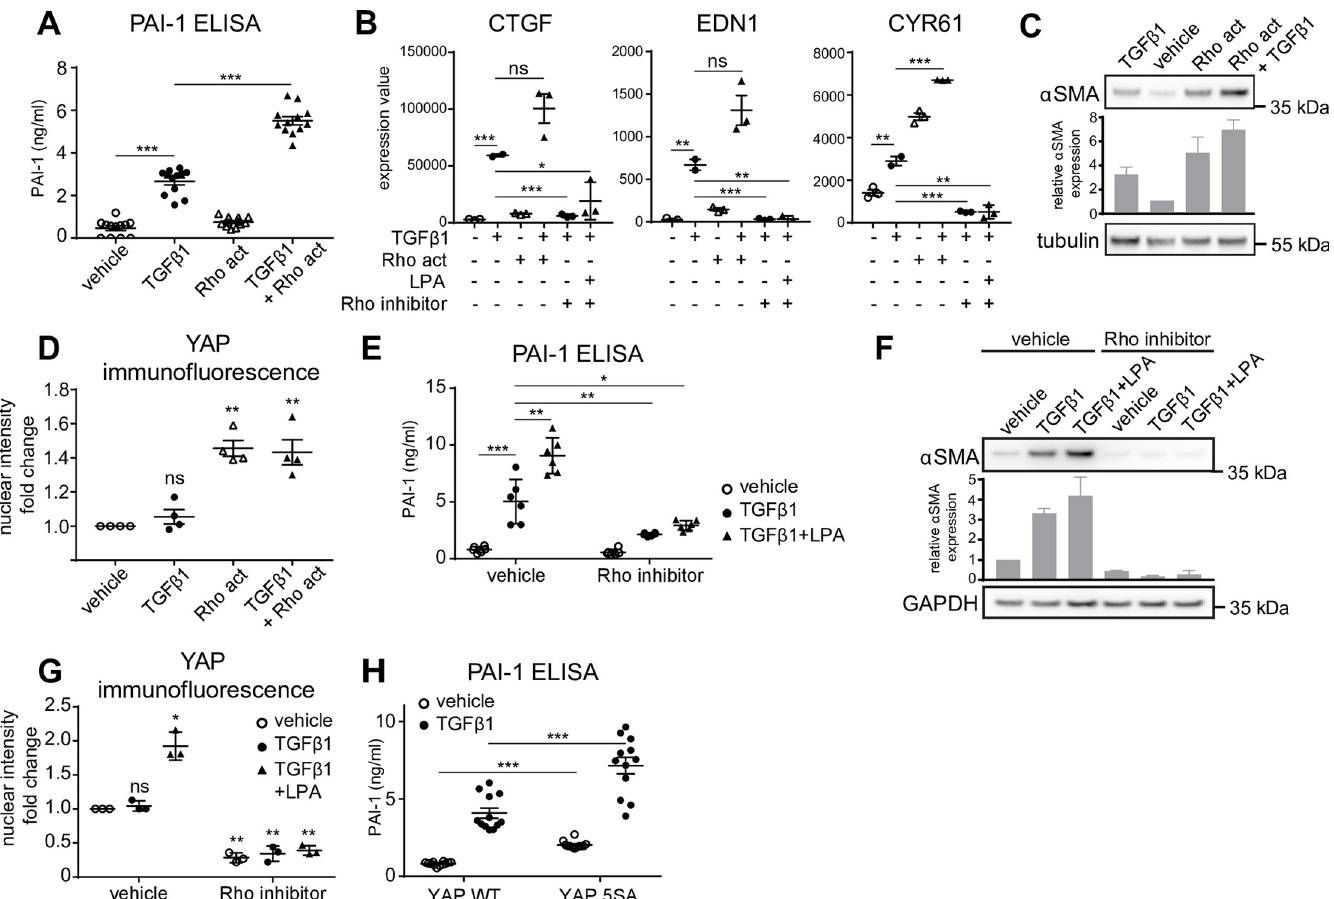
Fig 3. GPCR ligands regulate TGF β 1 response via the Rho/YAP axis. (A) Human dermal fibroblasts were starved and stimulated with 5ng/ml TGF β 1, 1ng/ml of Rho activator (Rho Act) or a combination of the two. PAI-1 levels in the cell supernatant were measured by ELISA after 24h (n = 9). Mean+/- SEM. (B) CTGF, EDN1 and CYR61 expression was measured by RT-qPCR after 3h in NHDF treated as indicated (n = 3). Mean+/- SEM. (C) α SMA levels were determined by western blot at 24h in cells treated as in A. The signal for α SMA was measured by image densitometry and expressed as relative value compared to vehicle-treated sample (n = 2). Mean+/- SEM. (D) NHDF were starved and stimulated with 5ng/ml TGF β 1, 1ng/ml of Rho activator (Rho Act) or a combination of the two for 1h. The nuclear intensity of YAP was analyzed by high content imaging of cells stained with anti-YAP antibody. Results were normalized to vehicle-treated cells (n = 4). Mean+/- SEM. One sample t-test was performed comparing normalized treatment effects to value 1 (vehicle). (E, F) NHDFs were starved, pretreated with Rho inhibitor (2ng/ml) and stimulated with 5ng/ml TGF β 1, 1 μ M LPA or the combination. PAI-1 levels in the cell supernatant were measured by ELISA after 24h (n = 6). Mean+/- SEM. α SMA levels were determined by western blot at 24h. The signal for α SMA was measured by image densitometry and expressed as relative value compared to vehicle-treated sample (n = 2). Mean+/- SEM. (G) NHDFs were starved, pretreated with Rho inhibitor (2ng/ml) and stimulated with 5ng/ml TGF β 1, 1 μ M LPA or the combination for 1h. The nuclear intensity of YAP was analyzed by high content imaging of cells stained with anti-YAP antibody. Results were normalized to vehicle-treated cells (n = 3). Mean +/- SEM. One sample t-test was performed comparing normalized treatment effects to value 1 (vehicle). (H) NHDF were transfected with myc-YAP WT or myc- YAP5SA and stimulated with 5ng/ml TGF β 1 or vehicle. PAI-1 levels in the cell supernatant were measured by ELISA after 24h (n = 12). Mean+/-